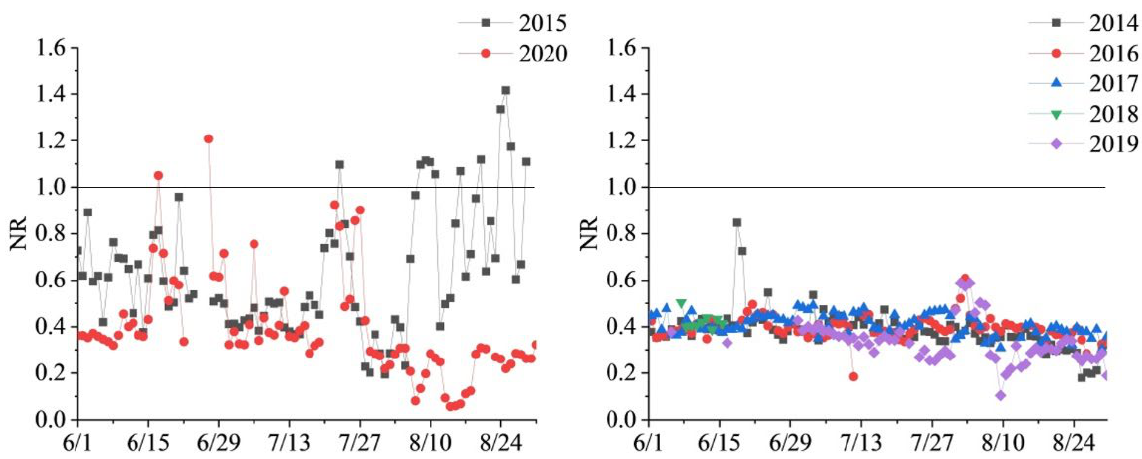
Figure 2. Changes in the neutralization ratio (NR) during the summers of 2014–2020.